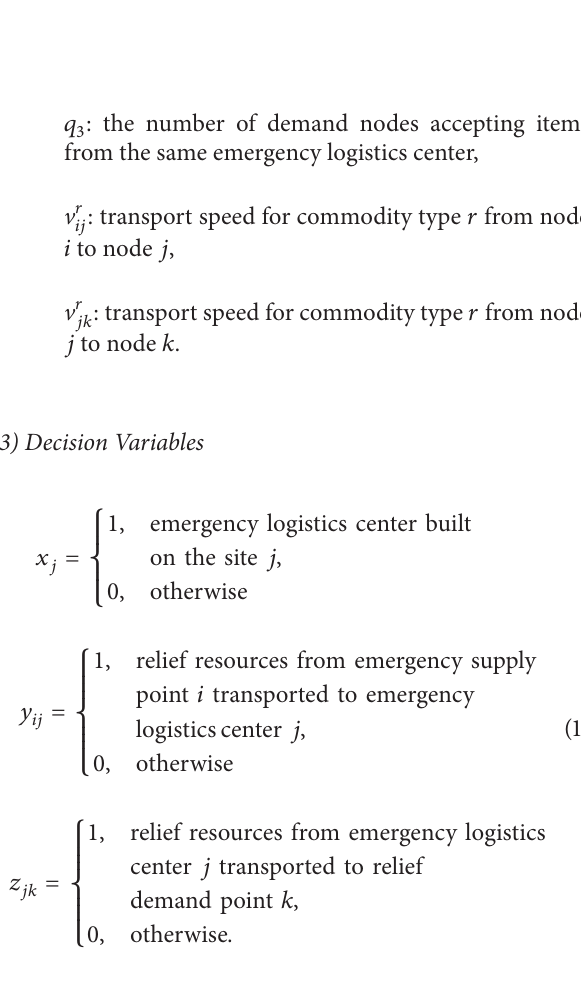
Figure 1: The queuing network of